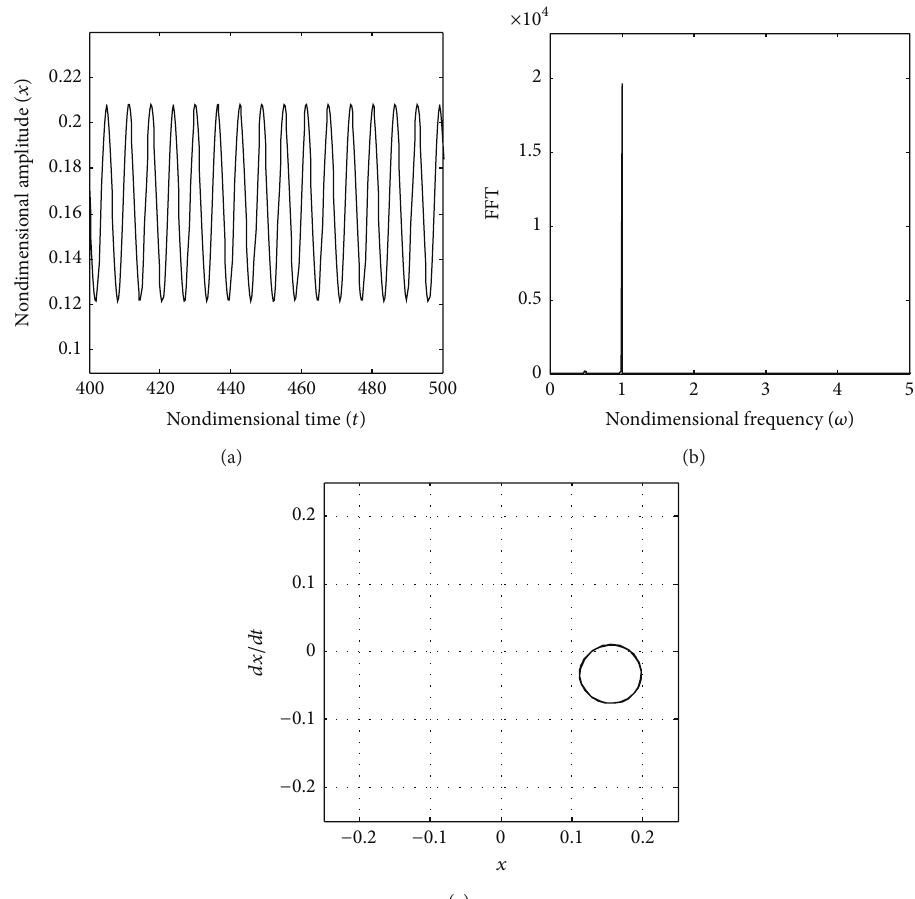
Figure 6: (a) Time history, (b) Fourier spectra, and (c) phase plane, for 𝑓 𝑝 = 0.3